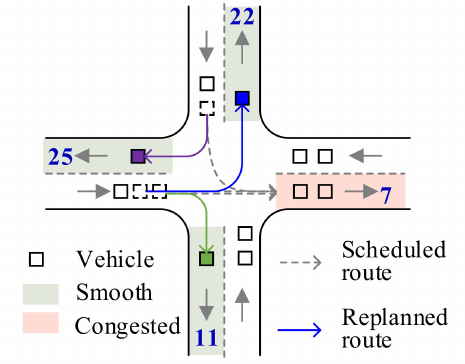
Figure 7. Route coordination planning at intersection 6 in the Nguyen